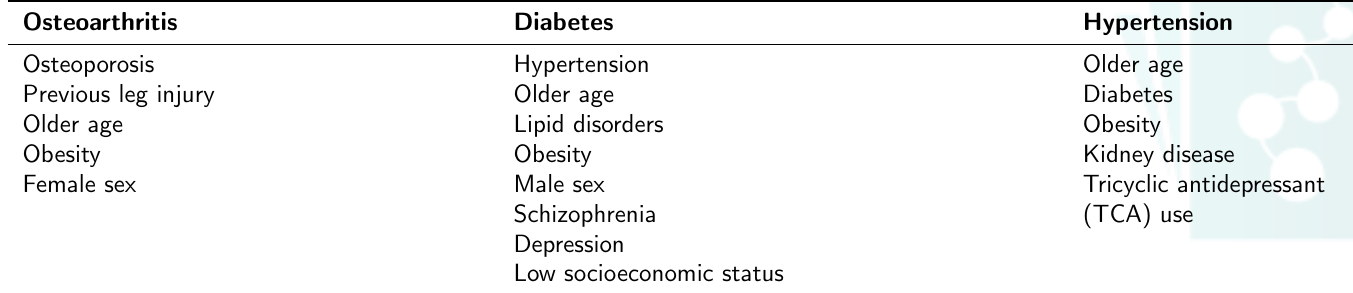
Table 1: Predictors available in CPCSSN